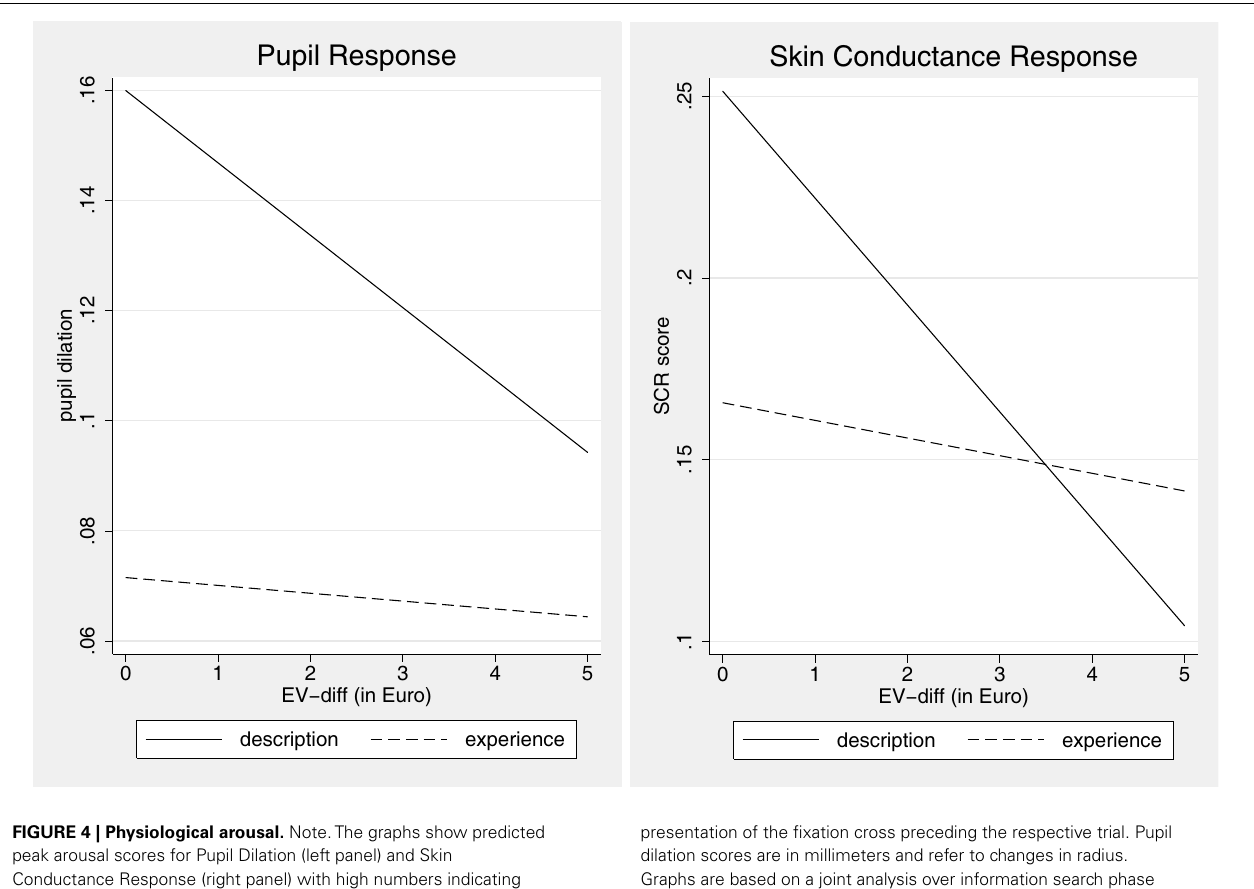
FIGURE 4 | Physiological arousal. Note.The graphs show predicted peak arousal scores for Pupil Dilation (left panel) and Skin Conductance Response (right panel) with high numbers indicating high arousal. Both scores are differences from baseline measured at